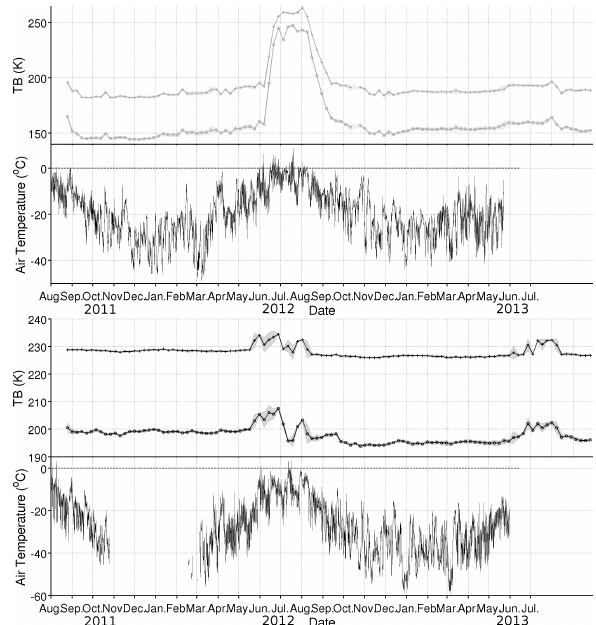
Fig. 4. Time series of TB (radiometer 1) at V (+) and H (o) polarizations, and GC-net air temperature measurements over South Dome (top two panels), and Summit (bottom two panels). The gray envelop corresponds to the weekly TB standard deviation.